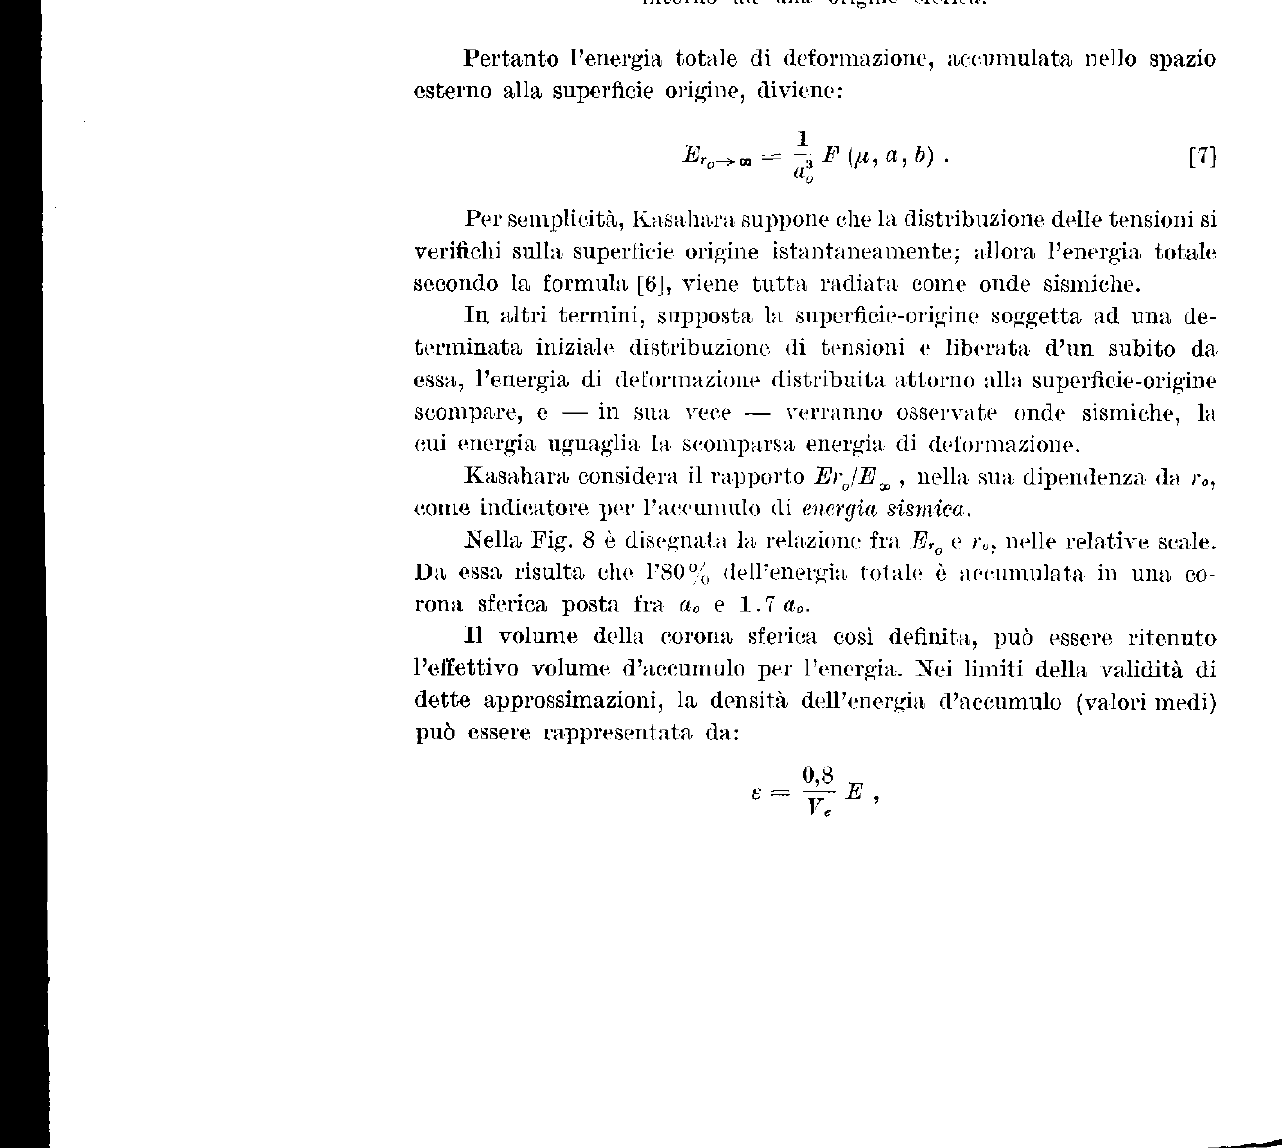
Fig. 7 - Accumulazione di deformazioni intorno ad una origine